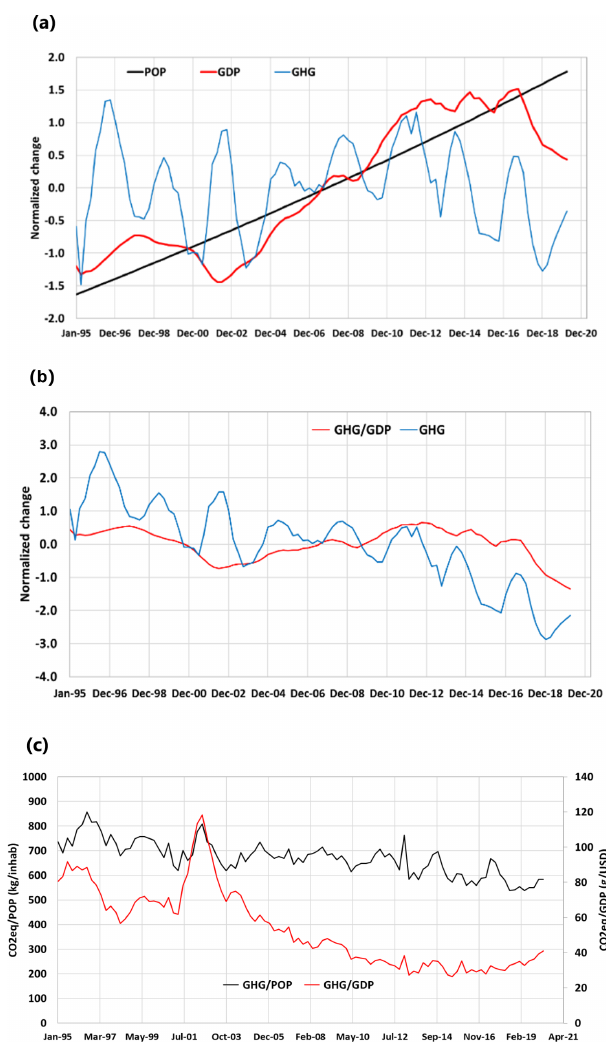
Figure A6. Normalized change in (a) population, gross domes- tic product, and GHGs in terms of CO 2eq between 1995 and 2020. (b) Population de-trended GDP and GHG. (c) De-trended GHG / cap (GHG emissions per capita (or inhabitants), units: kg/inhabitant) and GHG / GDP (GHG emissions per US dollar of gross domestic product, units: g/USD). The normalized function is obtained by subtracting the function mean value and divided by its standard deviation.